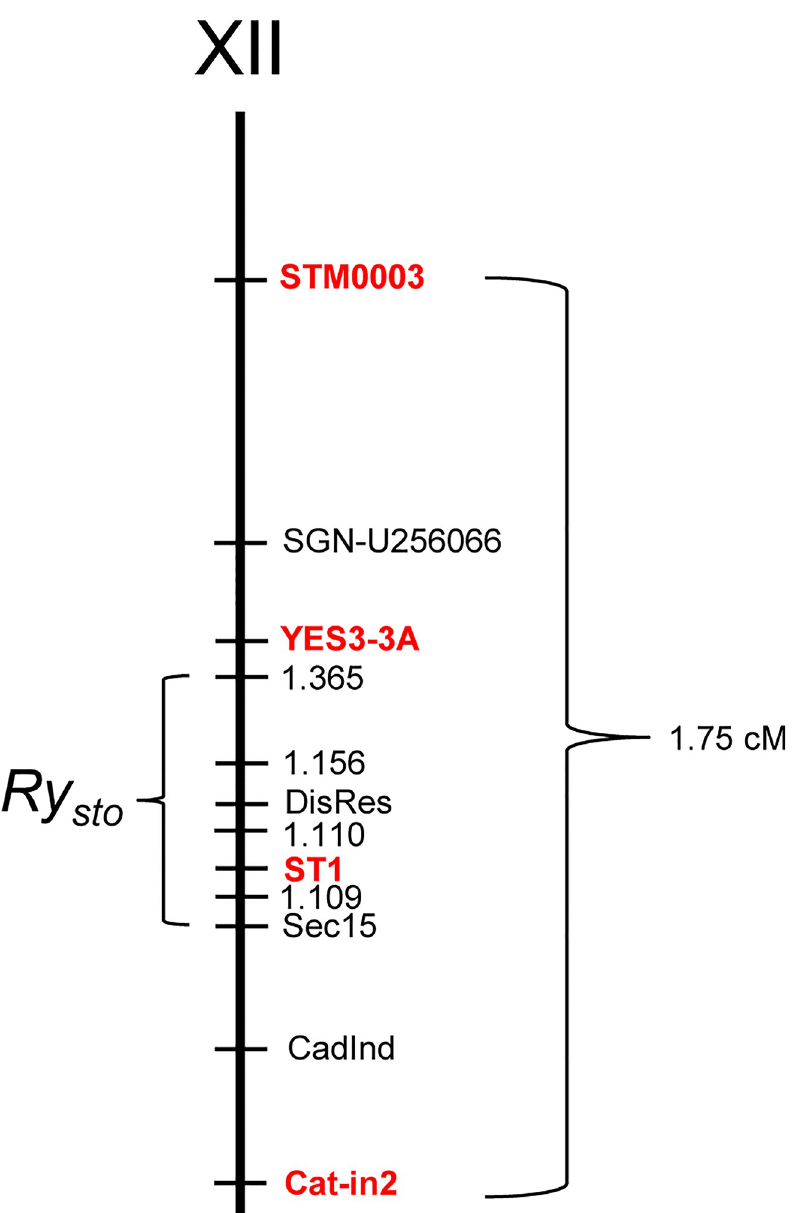
Fig 2. Position of the Ry sto locus on chromosome XII. The genetic distance in cM is shown on the right. The map distances for STM0003, SGN-U256066, YES3-3A, 1.365, Sec15, CadInd and Cat-in2 were calculated from recombination frequencies between DNA markers and resistance loci, whereas localisation of 1.156, DisRes, 1.110, ST1, and 1.109 were based on the Phureja genome sequence. Published markers are red-coloured.